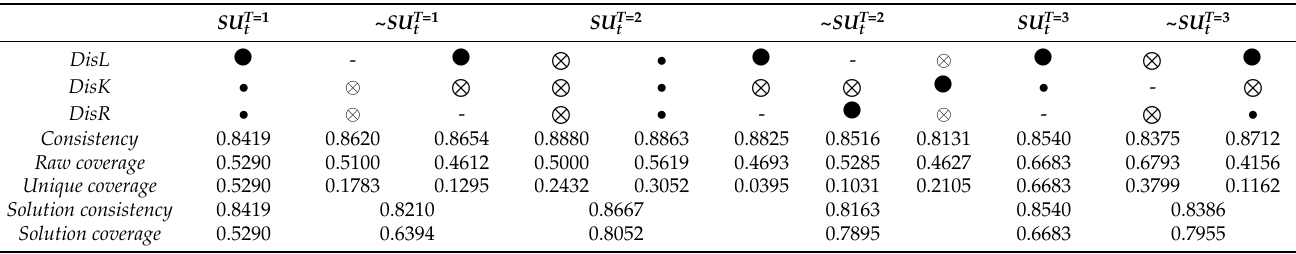
Table 6. Configuration of Influencing Factors for Upgrading Indicators of Marine Fishery Industrial